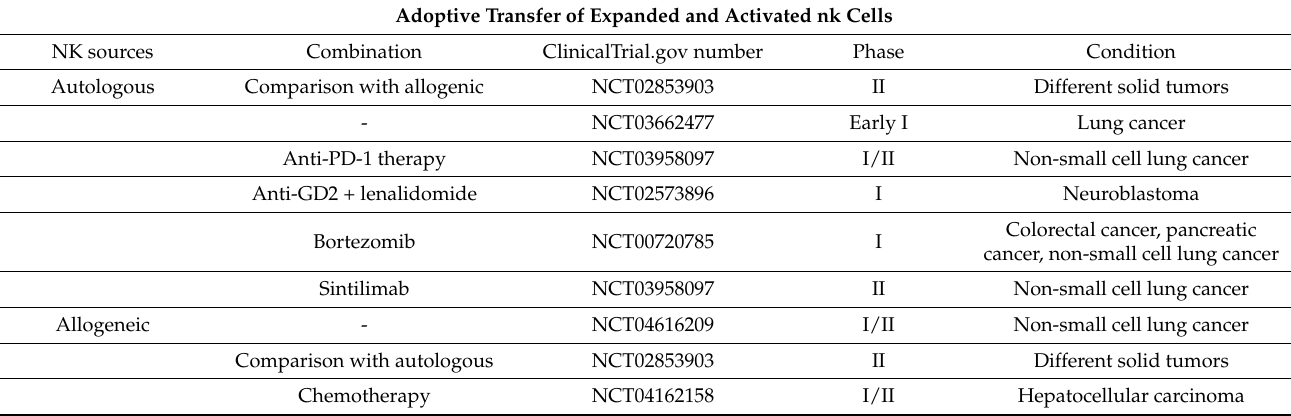
Table 1. Clinical trials of NK cells for adoptive immunotherapy of solid tumors. Adoptive Transfer of Expanded and Activated nk